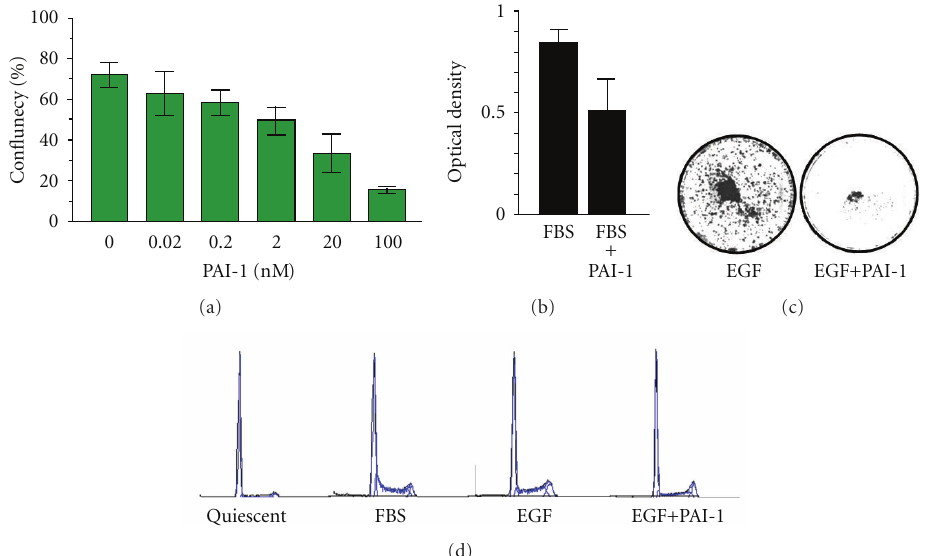
Figure 5: Increasing concentrations of PAI-1 (range 0.02 to 100 nM) e ff ectively suppressed growth of v- ras -transformants in serum-free (a) as well as serum-supplemented (b) media. In (b), PAI-1 was added to a final level of 20 nM. PAI-1 also inhibited EGF-induced HaCaT proliferation, as assessed by crystal violet staining of cells stimulated with EGF (10ng/mL) for 5 days in the absence or presence of PAI-1 (20nM) (c). Growth arrest in EGF-treated HaCaT keratinocytes reflected a PAI-1-induced G 1 block evident as early as 24 hours after the addition of PAI-1 compared to the prominent S-phase cohort in FBS- or control EGF-treated cultures (d). Starting quiescent populations (1 day in serum-free medium) were virtually devoid of DNA-synthesizing